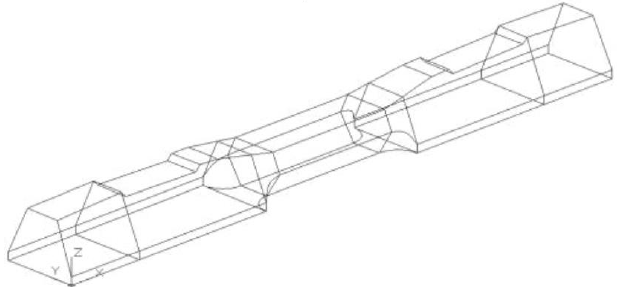
Figure 14. The railway sleeper assumed for a theoretical analysis (INBK-7 type).